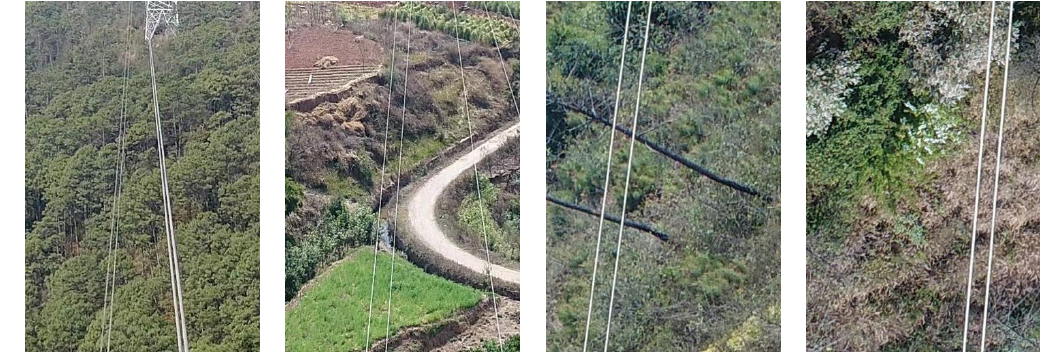
Figure 5. Example images of power lines in PLDM